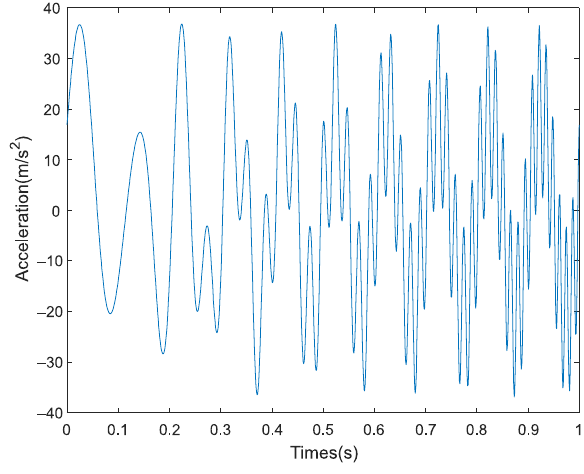
Figure 11. The signal with noise.